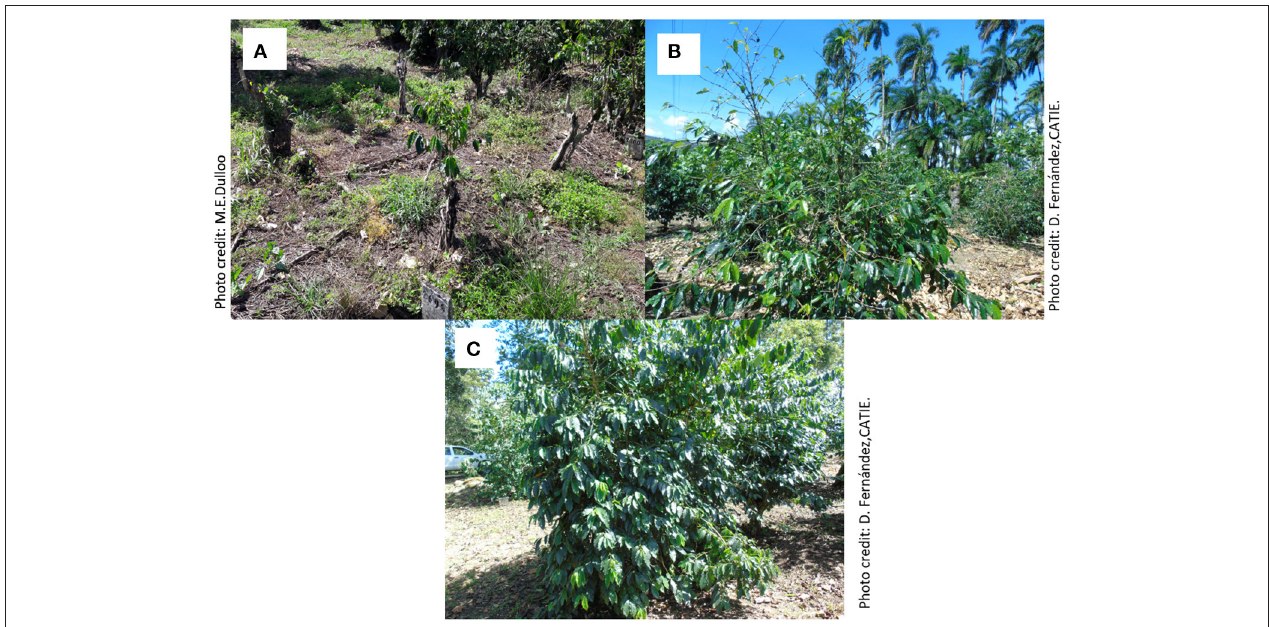
FIGURE 2 | Photographs showing health status of coffee plant in field genebank. (A) , Critical; (B) , poor; (C) , healthy.